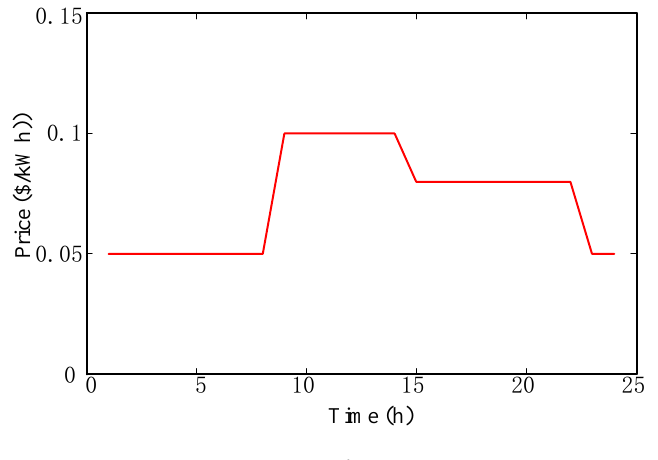
Figure 3. Time-of-use power price.